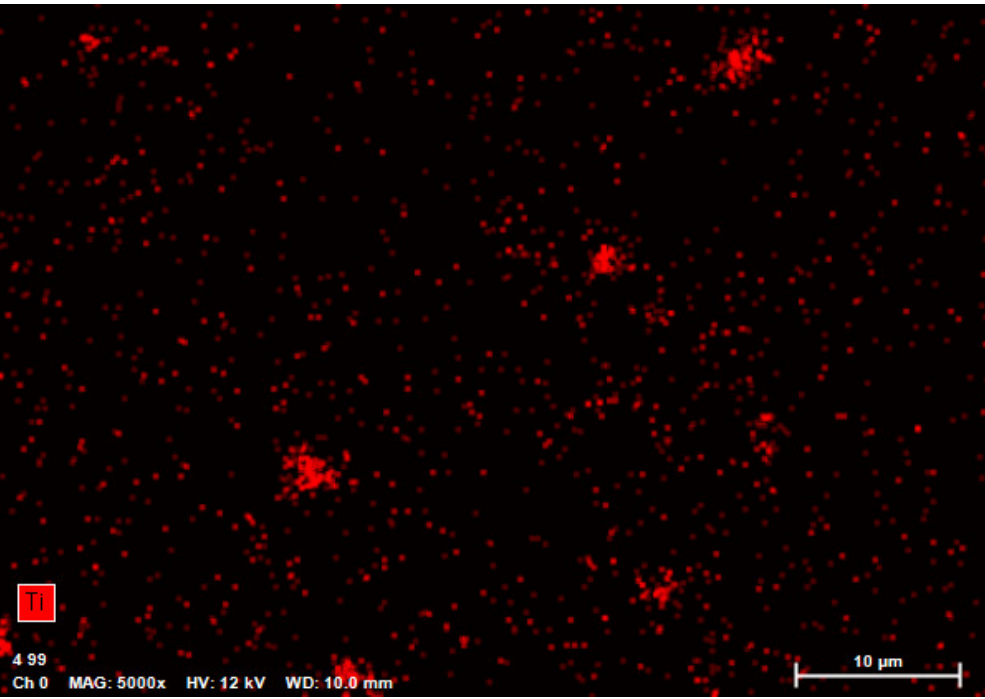
Figure 7. Element map of the nanocomposite for Ti (TiO 2 NPs Cp = 2 wt%) using EDS on SEM.